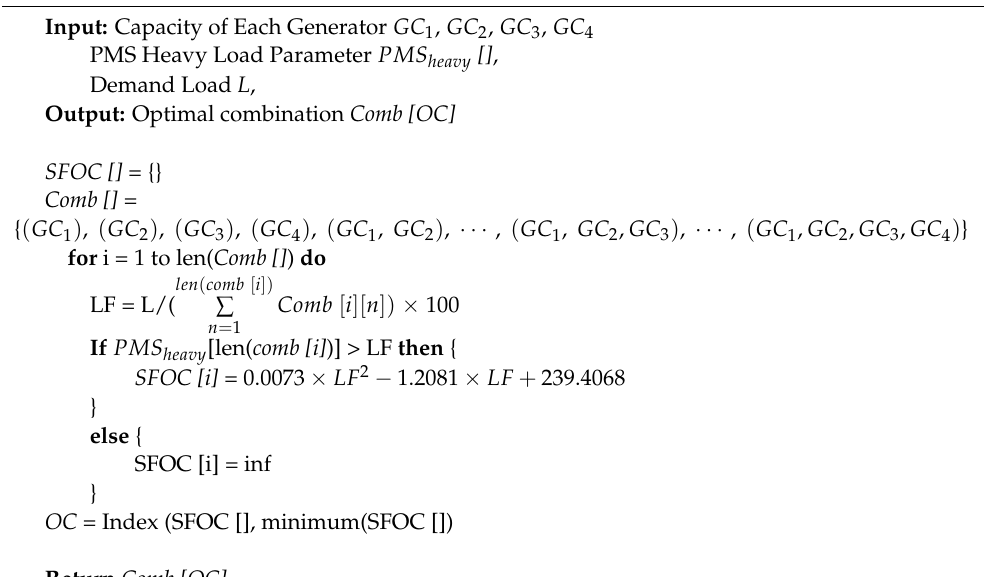
Algorithm 1. Find optimal combination of generator